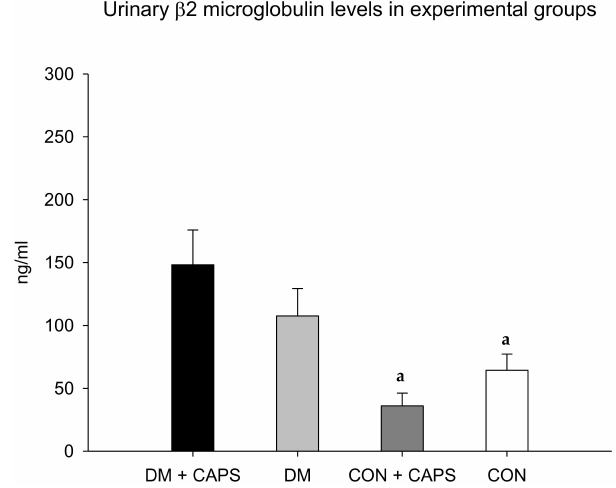
Figure 4. Effect of 8 weeks of capsaicin administration (1 mg/kg/day) on urinary β 2 microglobulin levels. ( a ) Statistically significant difference in comparison with the DM group + CAPS. Data are mean ± SEM.